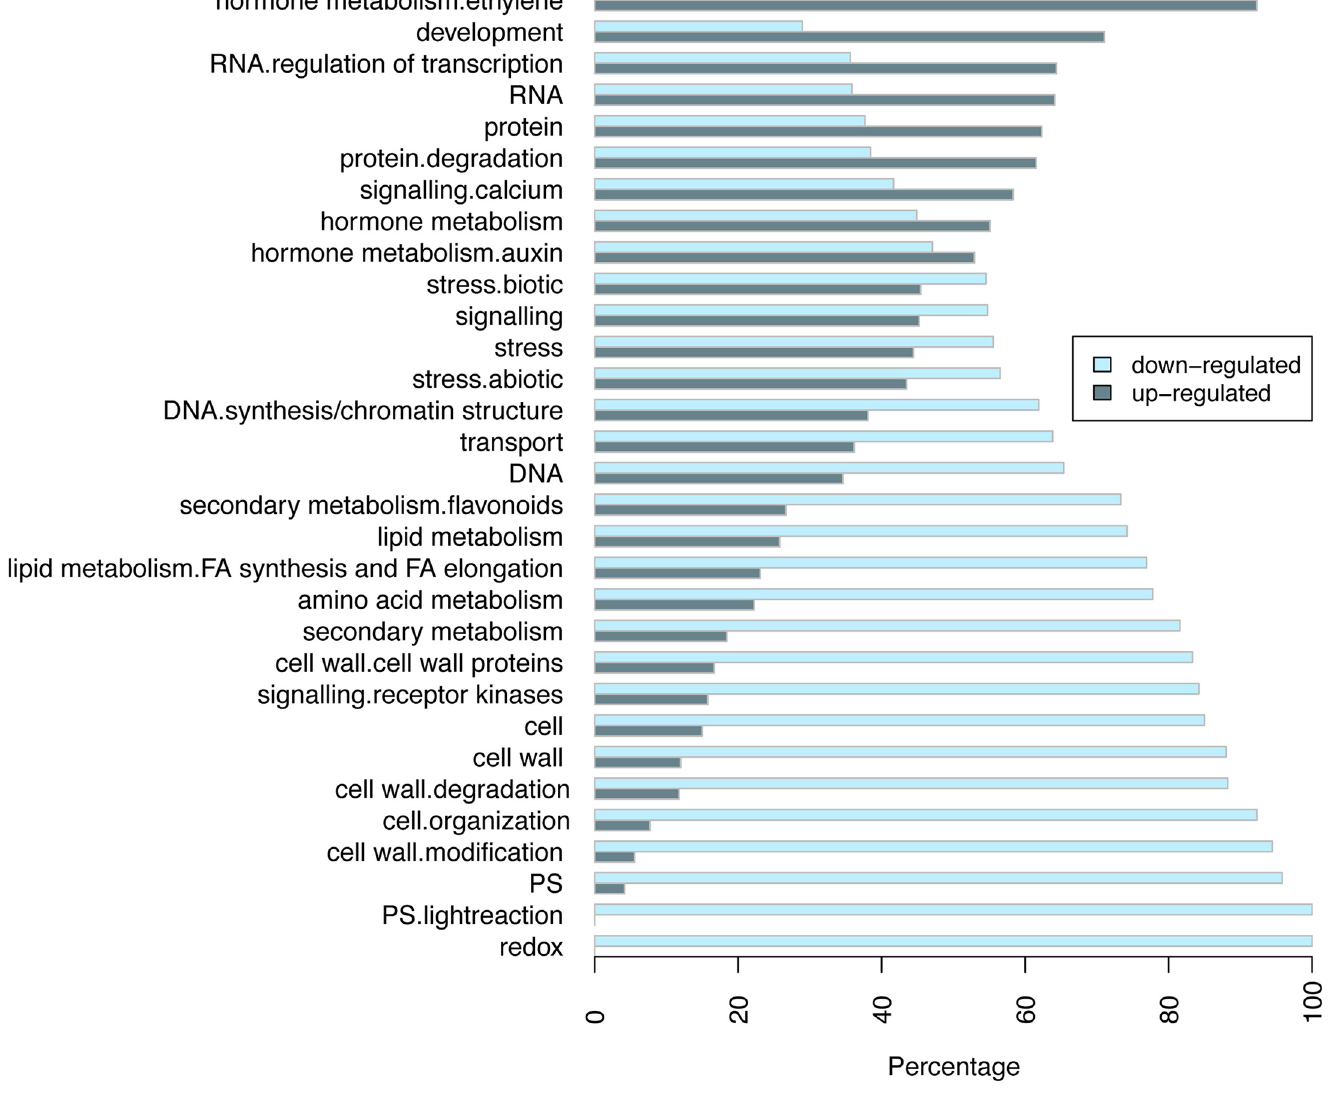
Fig 9. Percentage distribution of up- and down-regulated genes in VFP3 RNAi-1 plants as compared to the wild-type Col-0 plants. Annotation is based on MapMan categories. Categories with gene number less than 10 are not shown. Gray bars indicate up-regulated gene categories, and blue bars indicate down-regulated gene